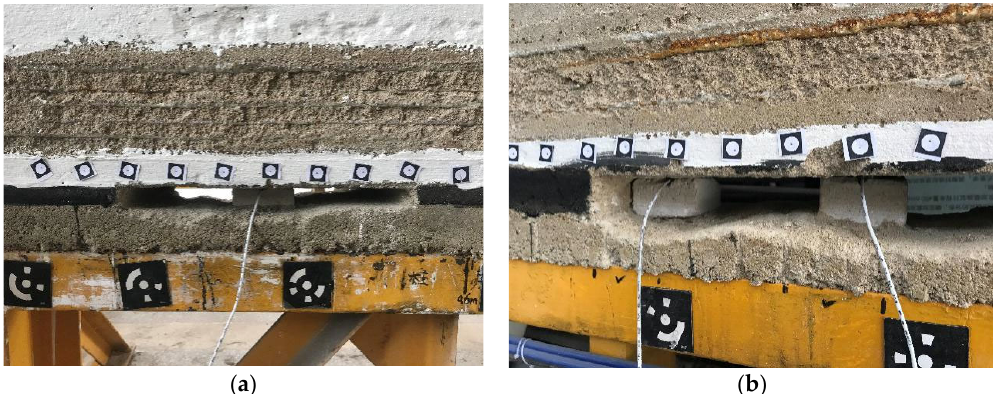
Figure 7. Schematic diagram of backfilling in the physical model.